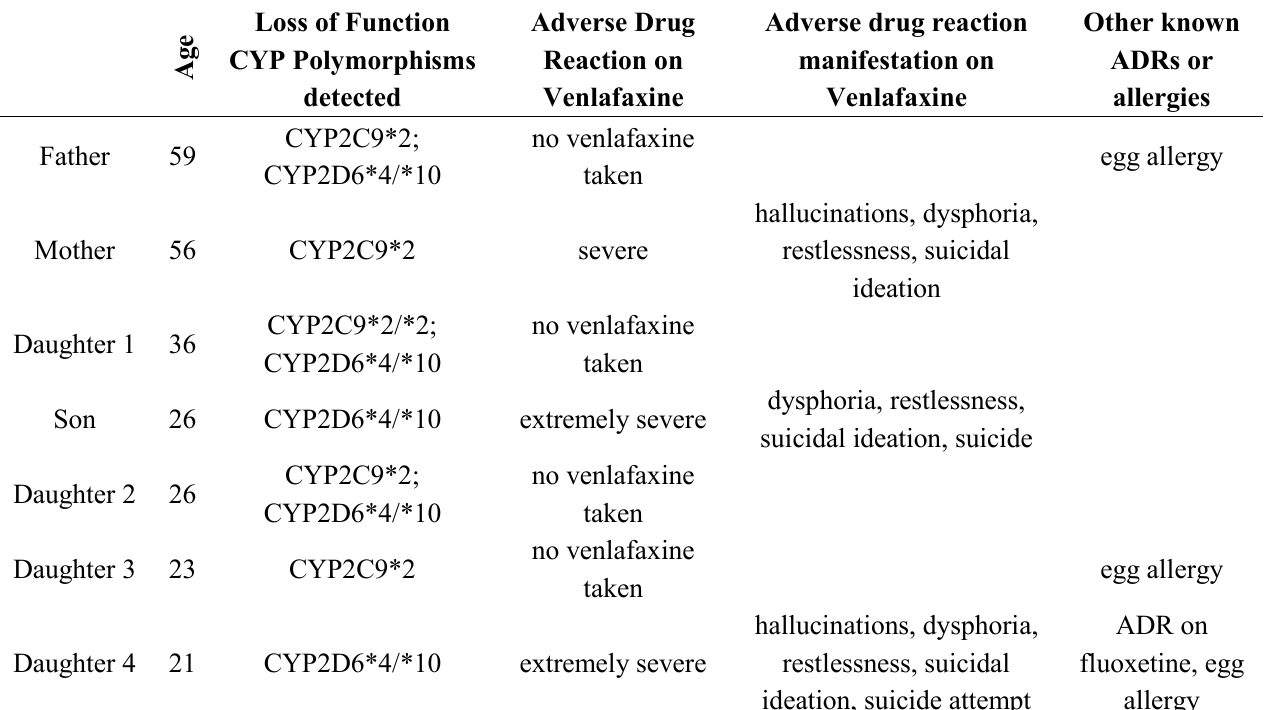
Table 1. Family X (case 2) genotype